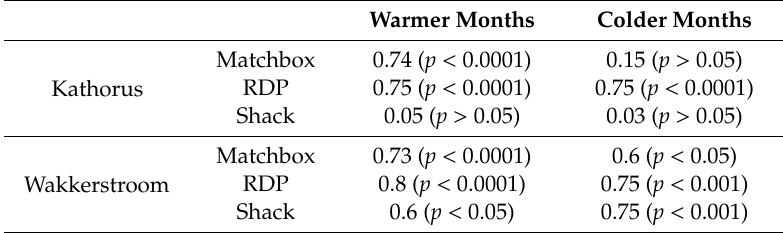
Table 1. Pearson’s correlation of outdoor temperatures vs. indoor temperatures in the Kathorus and Wakkerstroom